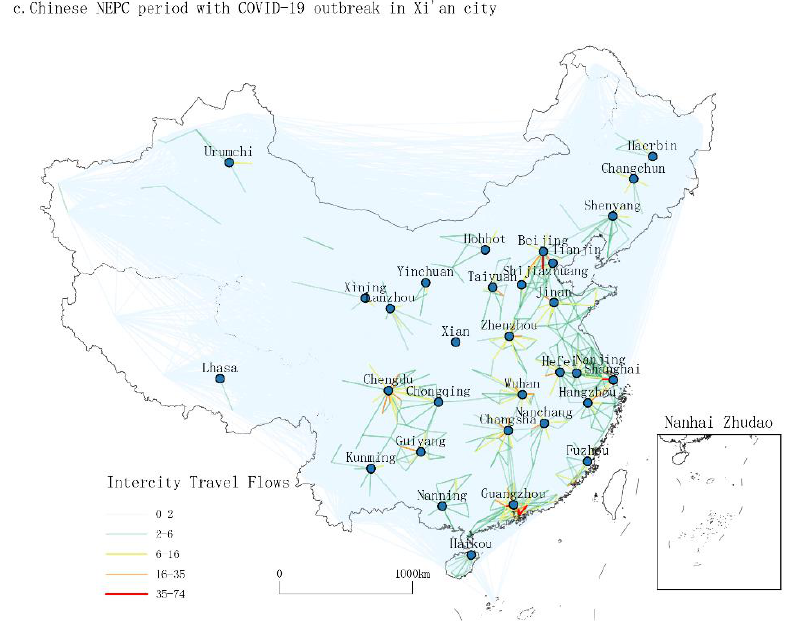
Figure 1. The figure shows the patterns of intercity travel flows in China during three periods before and after the COVID-19 epidemic. To clearly present the OD flow data, we averaged and scaled up the travel intensities. ( a ) Patterns of daily intercity travel before the outbreak of COVID-19 in De- cember 2019; ( b ) patterns of daily intercity travel in NEPC period without COVID-19 outbreak in Xi ’ an in December 2020; ( c ) patterns of daily intercity travel in NEPC period with COVID-19 out- break in Xi ’ an in December